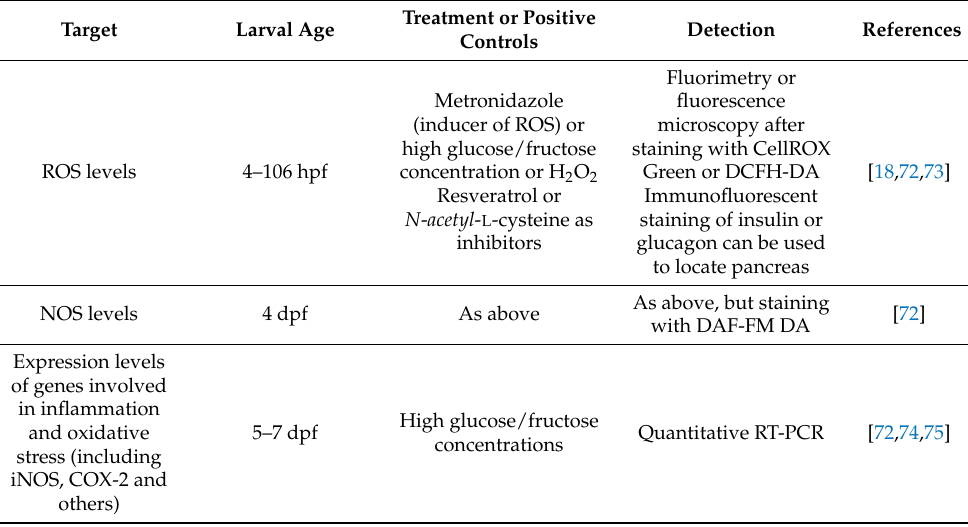
Table 2. Methods suitable for testing anti-inflammatory- and reduction of oxidative stress activity using wild-type zebrafish